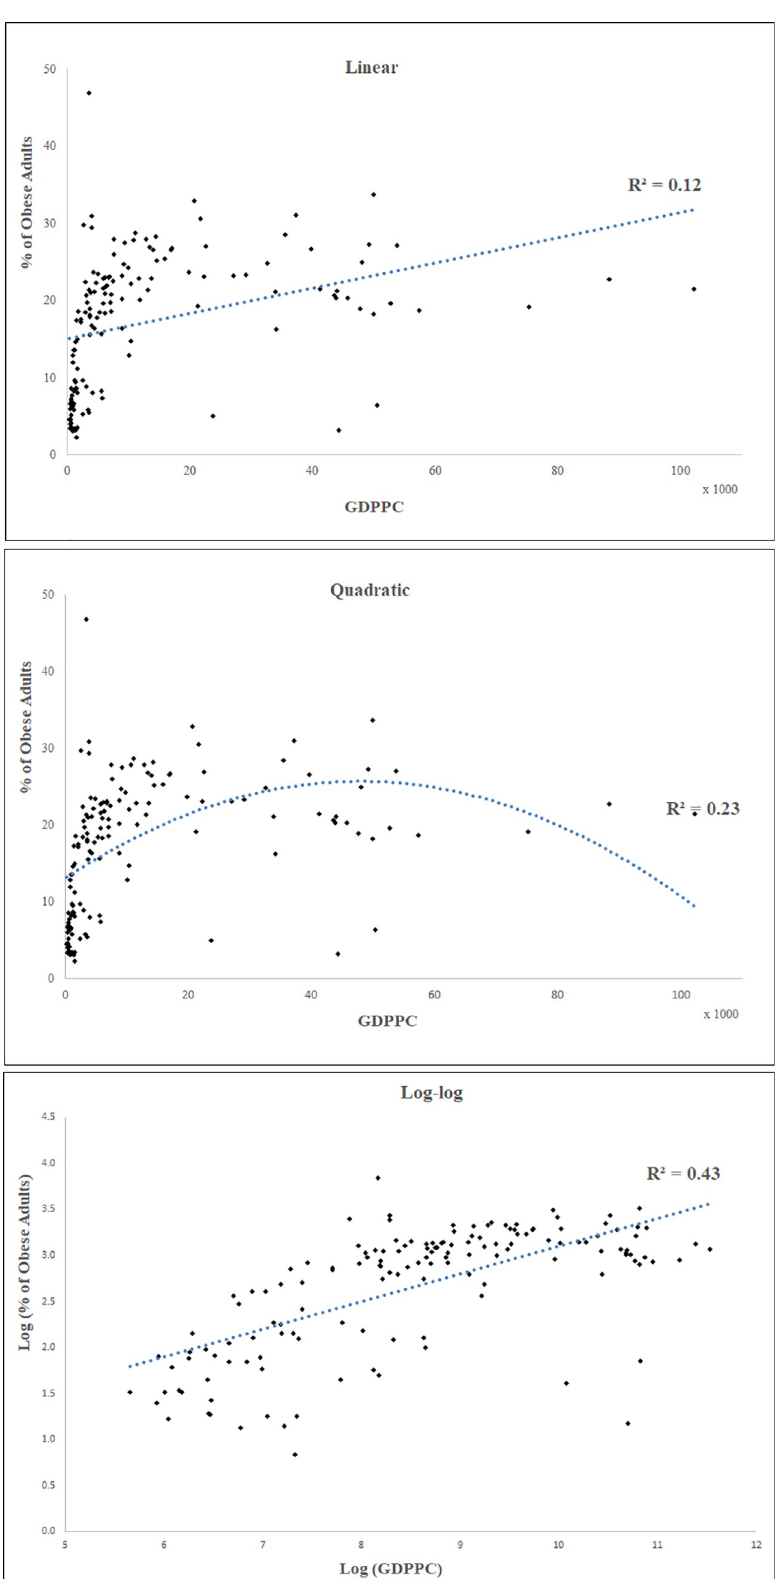
Fig 2. Relationship between obesity prevalence and national income (GDPPC). Trend lines are shown on the scatter plots of GDPPC vs. obesity prevalence along with R 2 values separately for the three functional forms–linear, quadratic and